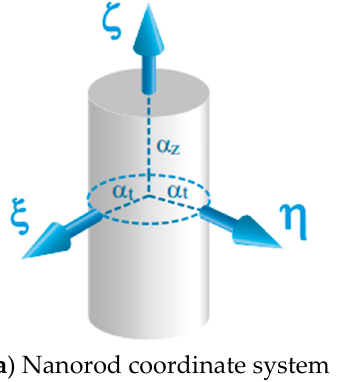
Figure 1. ( a , b ) respectively show the nanorod’s coordinate system ( ξ , η , ζ ) and the angle between the axis ( ξ ) of the nanorod and the ( x , y , z ) coordinate system ( θ 0 , ϕ 0 ). θ 0 represents the angle between the axis of the nanorod and the z-axis, and ϕ 0 represents the angle between the projection of the axis of the nanorod on the xoy plane and the x-axis.